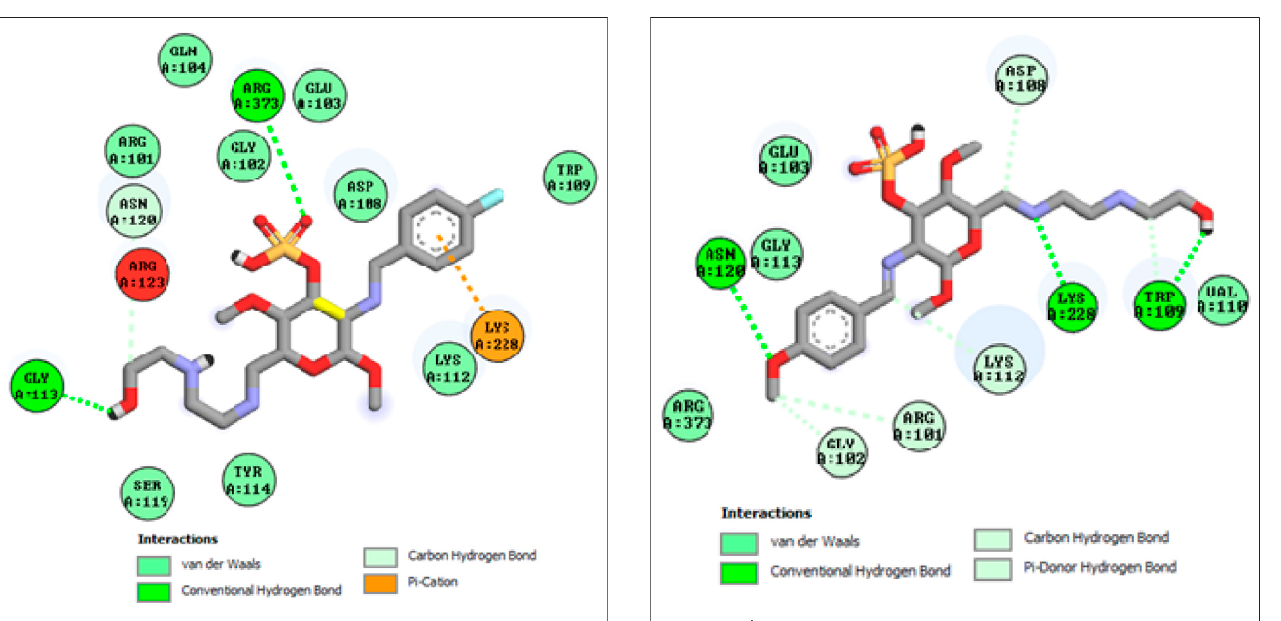
FIGURE 7 | Interaction of compound 2c in the binding pocket of 1Z11 receptor.